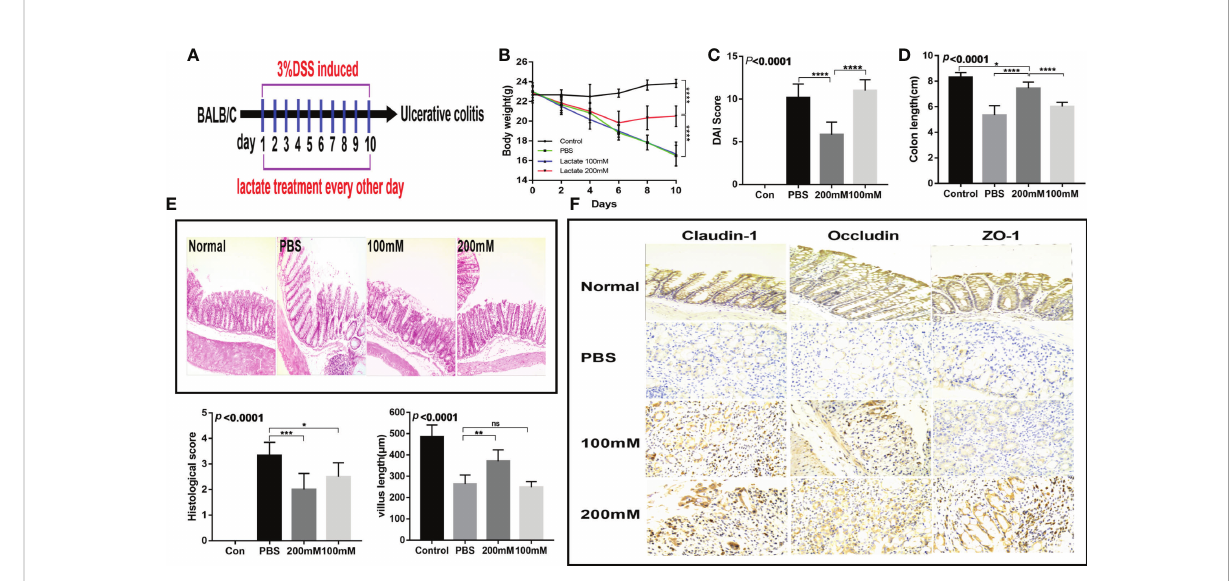
FIGURE 3 Lactate improved intestinal injury and intestinal mucosal barrier in mice with colitis. (A) Therapeutic design of drug-induced acute colitis model mice (n = 6). (B) Body weight changes in mice after lactate treatment (n = 6). (C) Changes of disease activity index in mice after lactate treatment (n = 6). (D) Colon length of mice after different treatments (n = 6). (E) Representative images of HE staining of colon tissues and histological scores in different groups (n = 6). Scale bar, 100 m m. The length of intestinal villi of mice after different treatments (n = 6). (F)